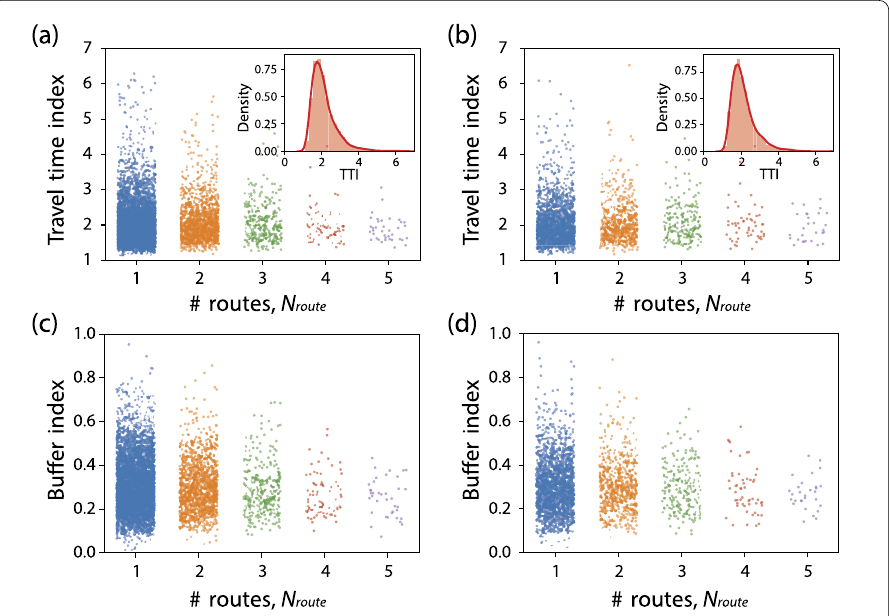
Figure 7 Travel time index and buffer index of users taking different number of trips. ( a ) Travel time index of the users with different number of routes during AM peak hours (7:00-10:00) on weekdays. The inset presents the distribution of TTI of all users during AM peak hours. ( b ) Travel time index of the users with different number of routes during PM peak hours (16:00-19:00) on weekdays. The inset presents the distribution of TTI. ( c ) Buffer index of the users with different number of routes during AM peak hours on weekdays. ( d ) Buffer index of the users with different number of routes during PM peak hours on weekdays